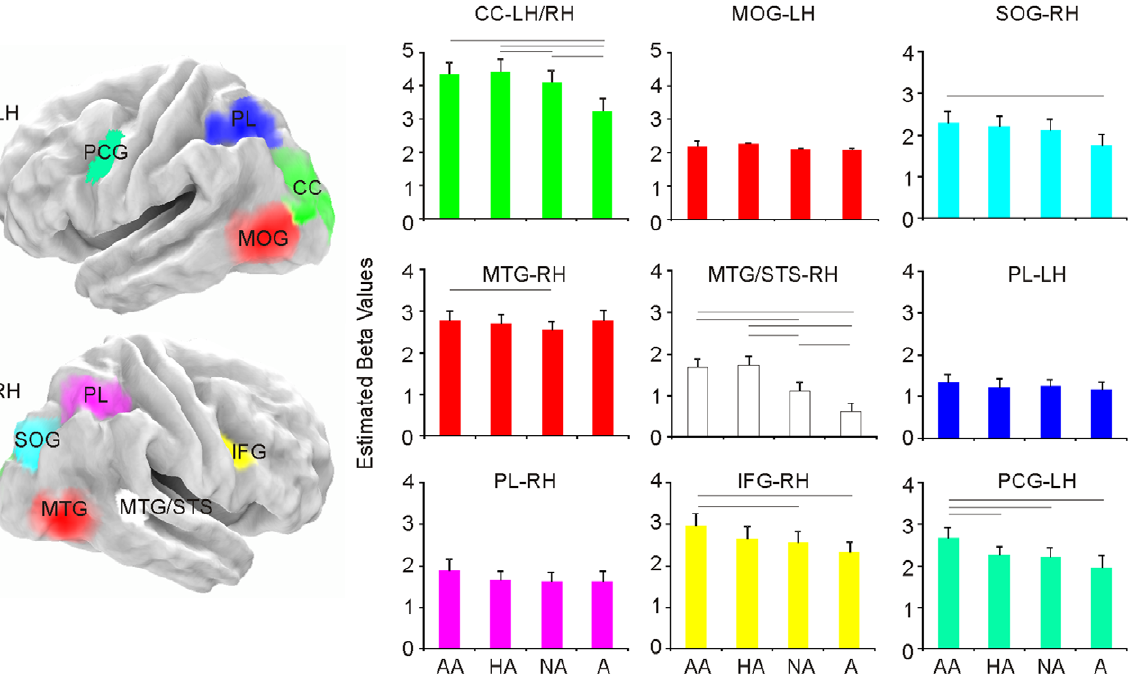
Figure 2. Regions showing different activation during the observation of any experimental condition compared with the intertrial baseline. Group activation data are rendered on the cortical surface of a ‘‘canonical’’ brain (Mazziotta et al., 1995). Plots represent estimated beta values for the AE and A conditions. Vertical bars indicate standard errors. Horizontal bars represent statistical differences.